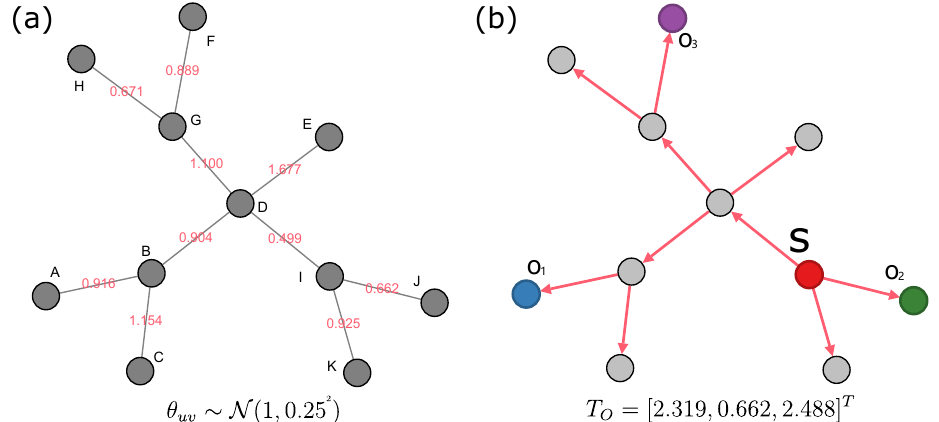
Figure 1. Illustration of the diffusion process on a representative tree. ( a ) topology of the tree and the underlying edge diffusion delay sampled from a Gaussian distribution θ uv ∼ N ( 1,0.25 ) ; ( b ) diffusion process from one source node s with initial time t 0 = 0, where { o 1 , o 2 , o 3 } denote three